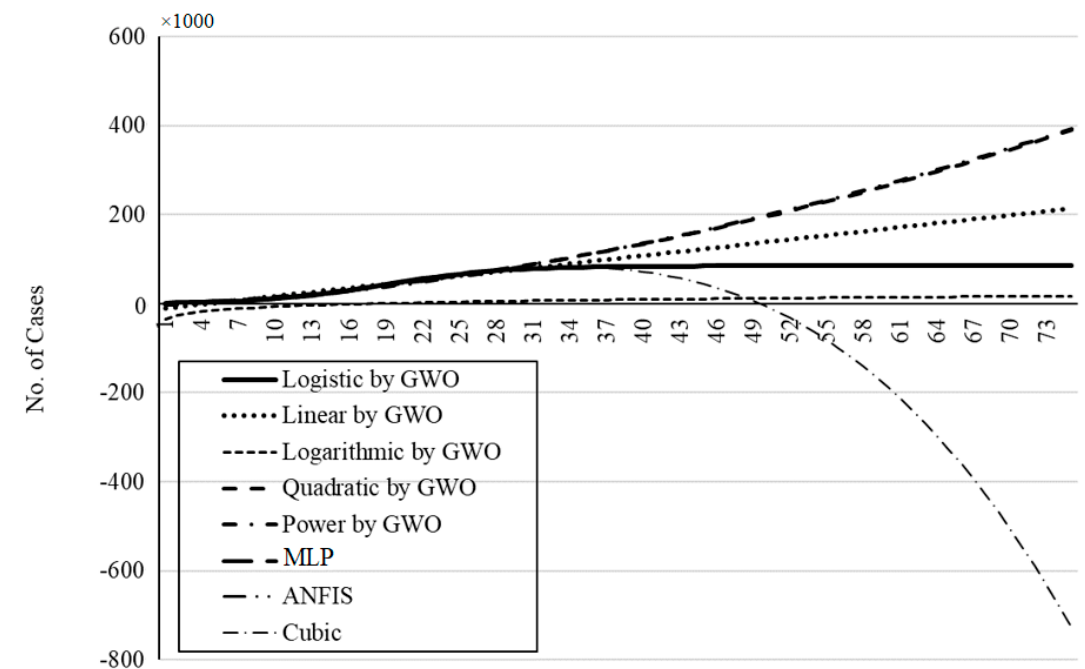
Figure 23. The outbreak prediction for China through 75 days.